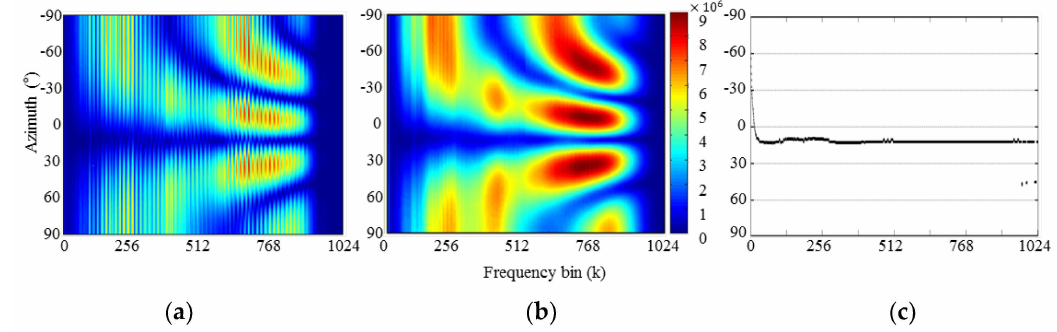
Figure 4. A-F planes and estimated direction for white noise in an anechoic room: ( a ) AF p k , θ q ; ( b ) AF s p k , θ q ; ( c ) estimated direction using AF s p k , θ q